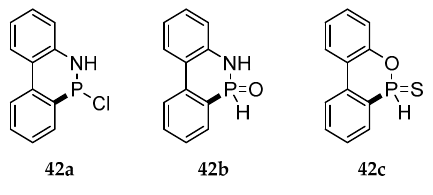
Figure 18. DOPO analogues.